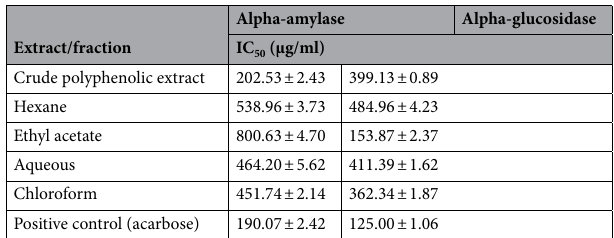
Table 3. The IC 50 (μg/ml) values of α-amylase and α-glucosidase enzymes inhibitory activities of the crude methanol extract of C. racemosa , its fractions (chloroform, hexane, ethyl acetate, and aqueous), and the standard drug.